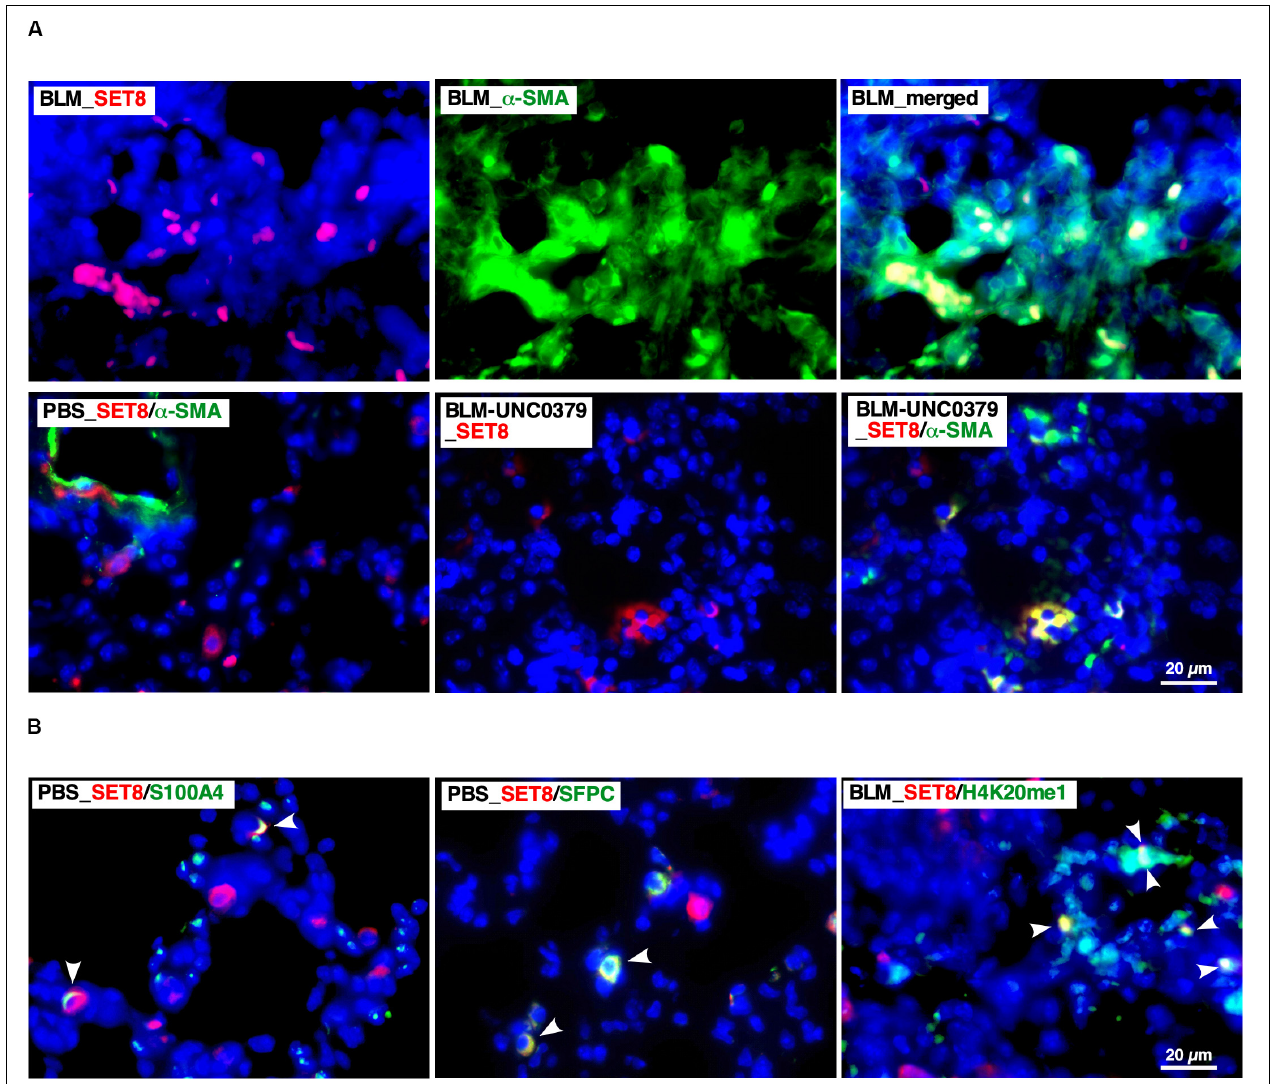
FIGURE 4 | Localization of SET8 in the lung under varying conditions. (A) Representative images of immunofluorescence staining of SET8 (red) and α -SMA (green) in lung sections obtained from mice in the BLM, PBS, and BLM-UNC0379 groups. Cell nuclei were stained with DAPI (blue). (B) Representative image of the immunofluorescence staining of SET8 (red), S100A4, SFPC, and H4K20me1 (green) in lung sections obtained from the PBS and BLM groups. Arrowheads indicate cells and nuclei double positive for the Abs.